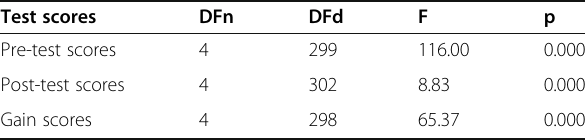
Table 3 Pre-test, post-test, and change scores ’ ANOVAs Test scores